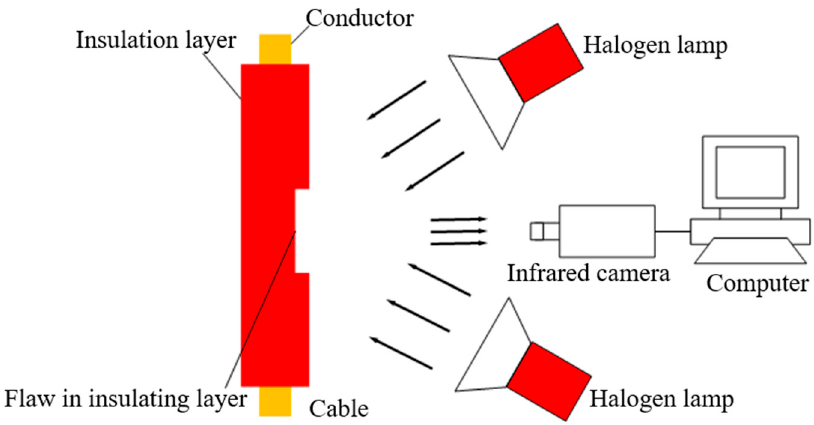
Figure 4. Experimental setup of the infrared testing system.